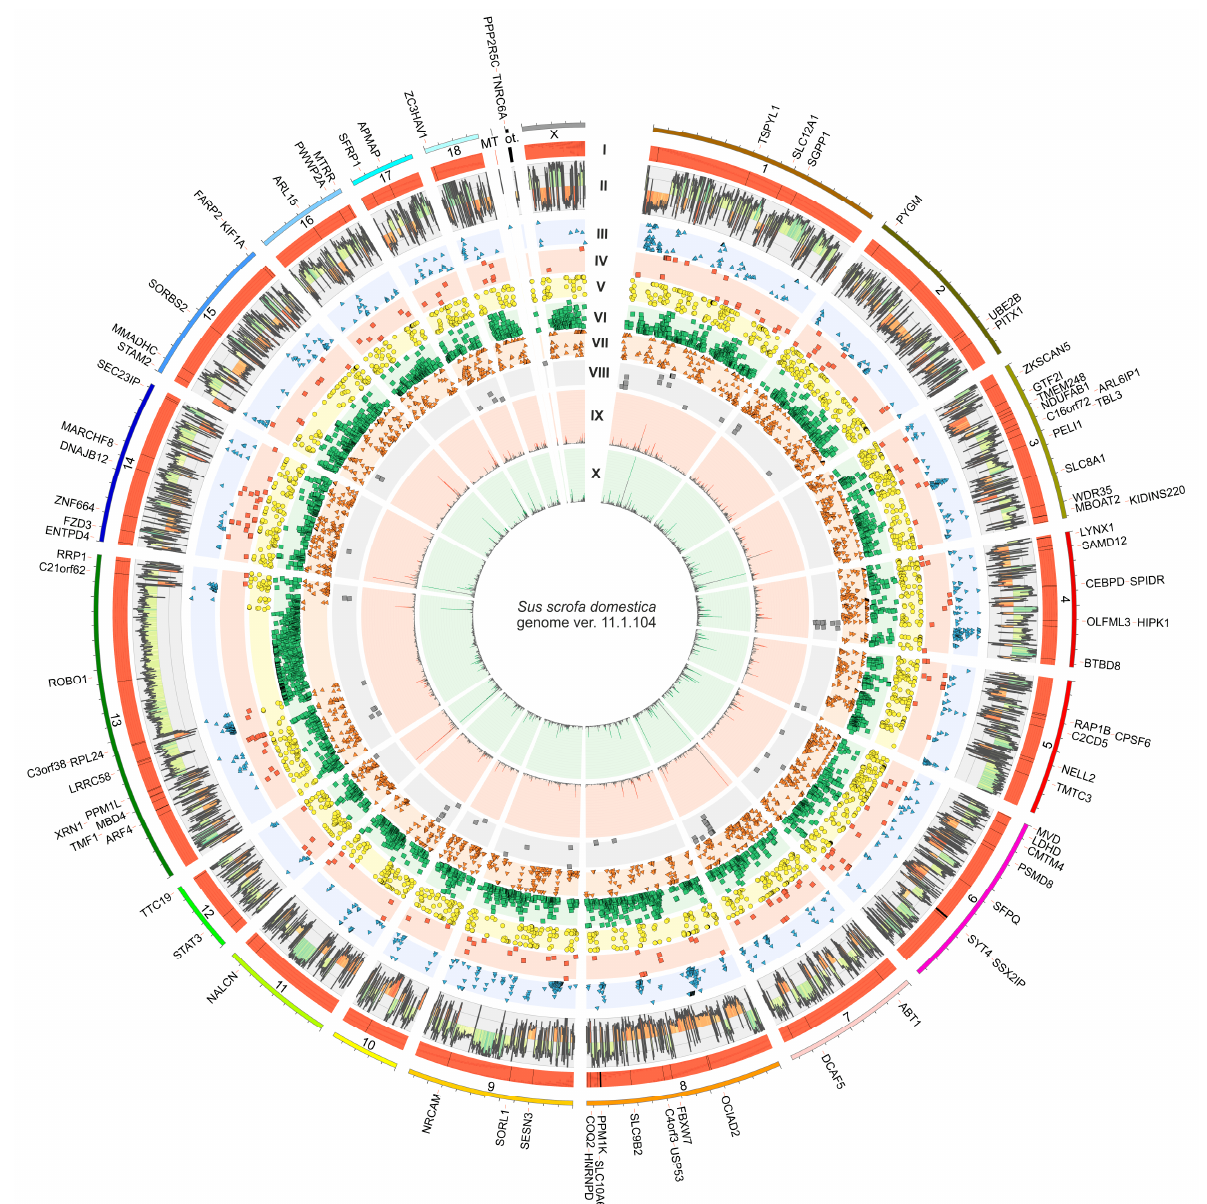
Figure 5. Visualization of the distribution within the domestic pig genome of identified allele-specific expression variants (ASEs) and RNA editing events alterations differentiating within porcine adenohypophyseal cells during the embryo implantation period (EP) compared to the mid-luteal phase of the estrous cycle (ML). The subsequent circles present the following data: I—distribution of ASEs (red bars) and RNA editing events (black stripes) on the porcine chromosomes, II—histogram of differences in alternative allele fraction ( ∆ AAF) values for identified events, III—sites localized within the intergenic regions, IV—sites localized within the 5 ′ untranslated regions (UTRs), V—sites localized within the coding DNA sequences (CDS), VI—sites localized within the intronic regions, VII—sites localized within the 3 ′ UTRs, VIII—sites localized within the noncoding regions, IX—histogram of sum of alternative allele coverage within EP samples and X—histogram of the sum of alternative allele coverage within ML samples. For circles III–VIII, the distance from the circle’s center symbolizes the significance level, expressed as − log 10 (false discovery rate). Gene names on the outside of the circle mark the positions of identi fi ed RNA editing events.